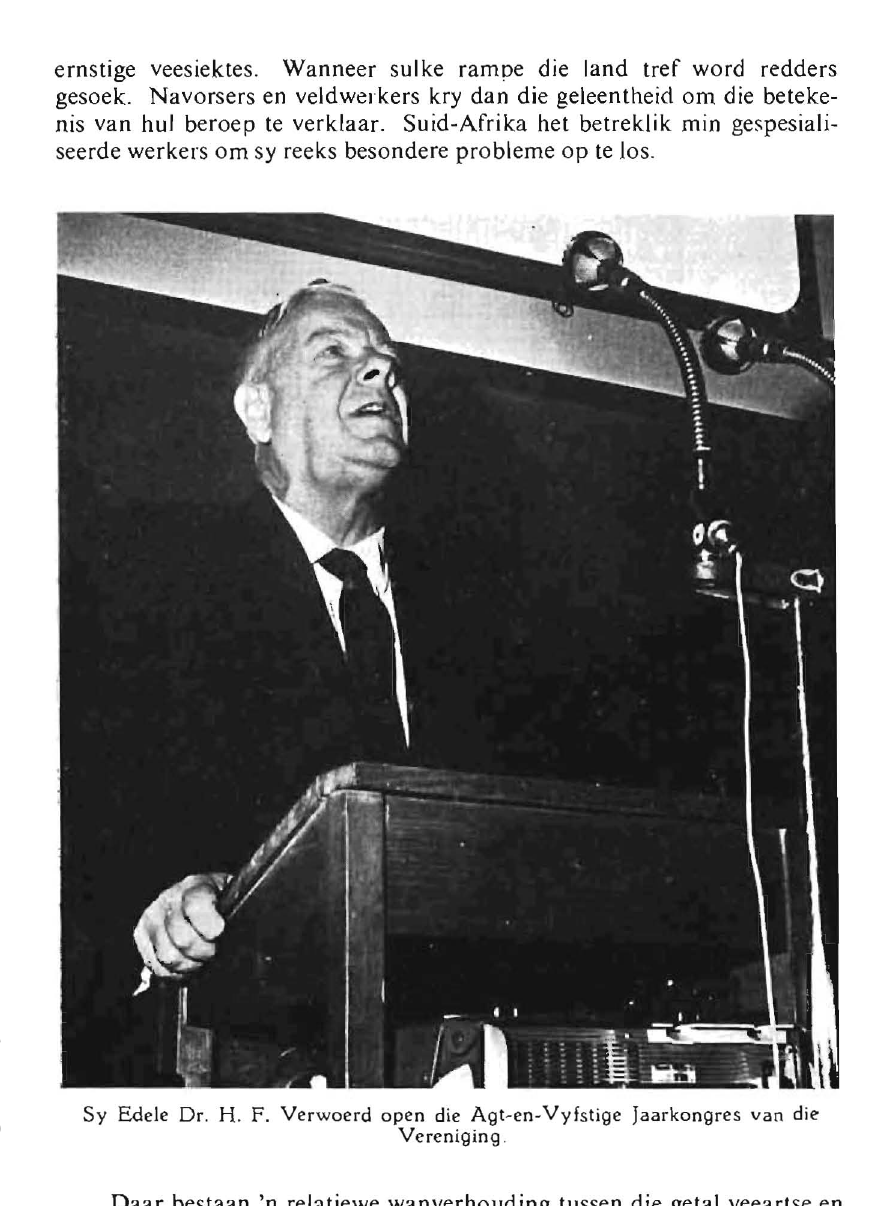
Daar bestaan 'n relatiewe wanverhouding tussen die getal veeartse en die veebevol king van die land. Miskien is ons vee in die algemeen baie gesond of hulle behou hulle gesondheid beter met die minimum van veeartse. Die baie terreine wat hierdie klein volkie moet dien is 'n oor tuiging van sy standvastigheid. Die tekort aan opgeleide personeel mag binne aansienbare tyd oorwin word. Wat veeartsenykunde betref word die oorwinning behaal deur die deeglike \\-erk wat die Instituut lewer. In samewerking met die boere k'" n baie vordering gemaak word en kan kontak tussen die geleerdes en die leke verbeterings